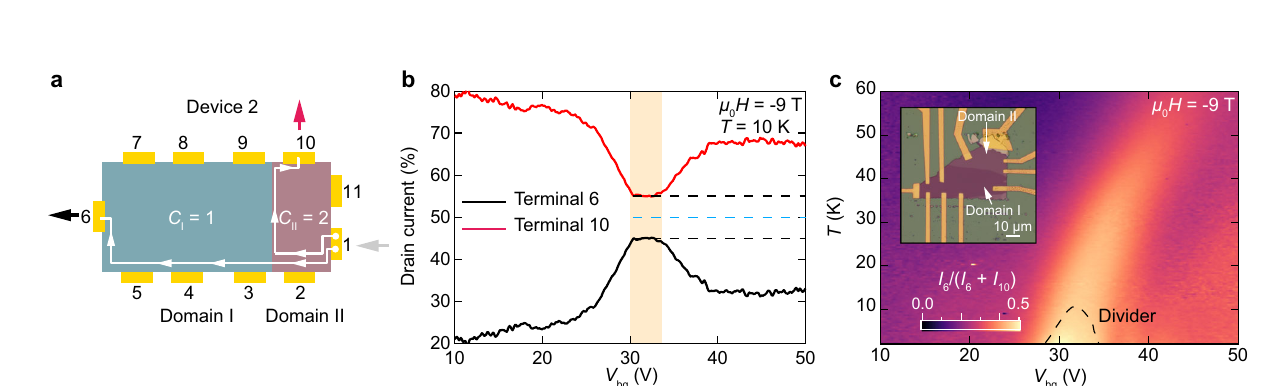
Fig.4|Robustnessofthechiraledgecurrentdividertotemperature.a Device2 measurement scheme. Domains I and II are tuned to Chern number s of 1 and 2, respectively.Currentisinjectedatcontact1(grayarrow)anddetectedatcontacts6 (black) and 10 (red). Winding of edge states is clockwise at μ 0 H = − 9 T. Yellow shaded area denotes the gate range where Chern insulator junction forms and functionsasa1:1currentdivider. b Normalizeddraincurrentversus V bg forcontacts